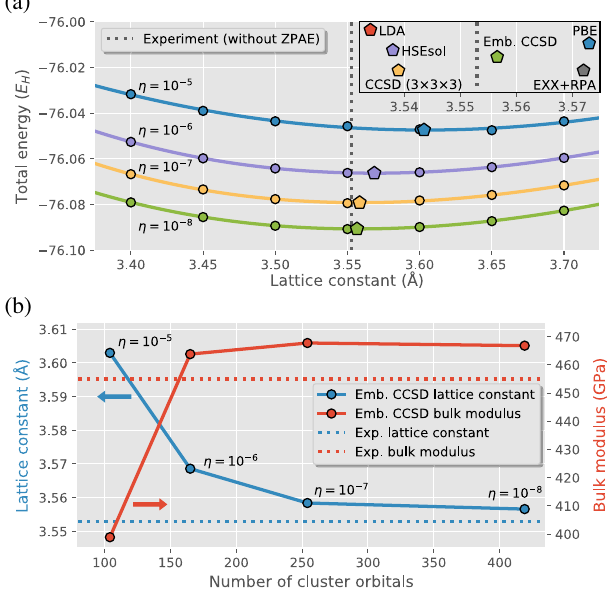
FIG. 4. (a) Total energies of embedded CCSD of 5 × 5 × 5 diamond for different bath thresholds η . The pentagons mark the minima of the fitted equation of states (solid lines). Inset: comparison of the embedded CCSD lattice constant to literature DFT results from Refs. [63,64], using the PBE functional [65], the HSEsol functional [64], and the EXX þ RPA functional [9], and CCSD results from Ref. [7]. (b) Convergence of lattice constant and bulk modulus with respect to the number of active cluster orbitals at each η . All experimental values are corrected for zero-point anharmonic expansion (ZPAE)